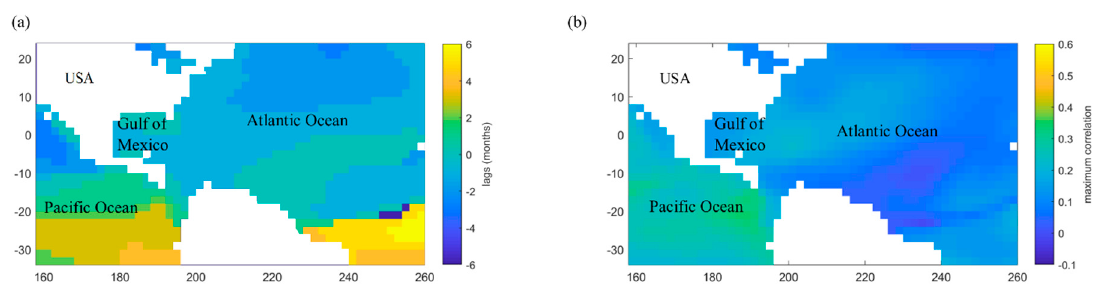
Figure 2. ( a ) Lag / lead months in each grid and ( b ) maximum grid-point correlation of Sea Surface Temperature (SST) with Groundwater Storage Anomaly (GWSA).